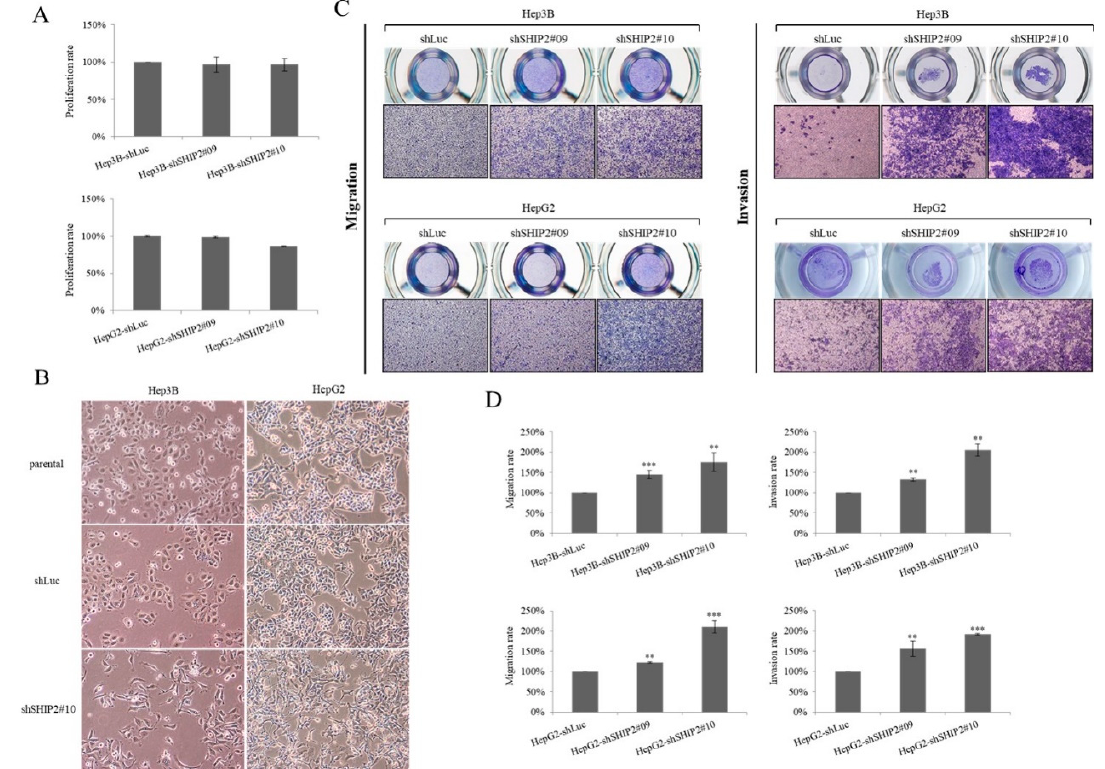
Figure 4. Inhibition of SHIP2 enhances cell migration and invasion in HCC cell lines. ( A ) The proliferation ability of Hep3B and HepG2 cells grown in 96-well plates was assessed using a WST-1 assay for a period of 24 h after SHIP2 shRNA knockdown. ( B ) Representative images of cell morphology in parental, shLuc, and shSHIP2 cells. Magnification, 100×. ( C ) Cell migration and invasion were measured using Transwell assays for shLuc, and shSHIP2 cells. Representative photographs from at least three different experiments are shown. Magnification, 100× ( D ) The relative migration and invasion rates of cells as shown in (C) were determined by crystal violet staining and quantification. Statistical analysis was performed with a Student’s t -test. ** p < 0.01; *** p < 0.001 as compared with the shLuc group ( n = 3).